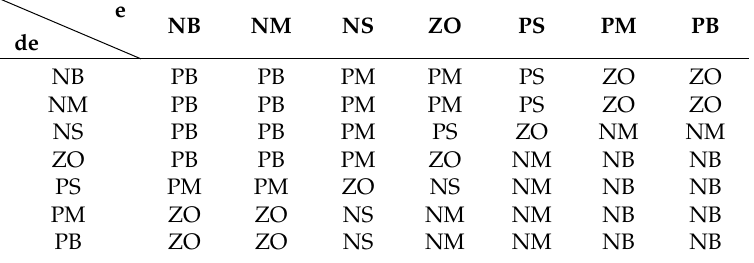
Table 1. Control rules of diesel engine speed by fuzzy logic control.